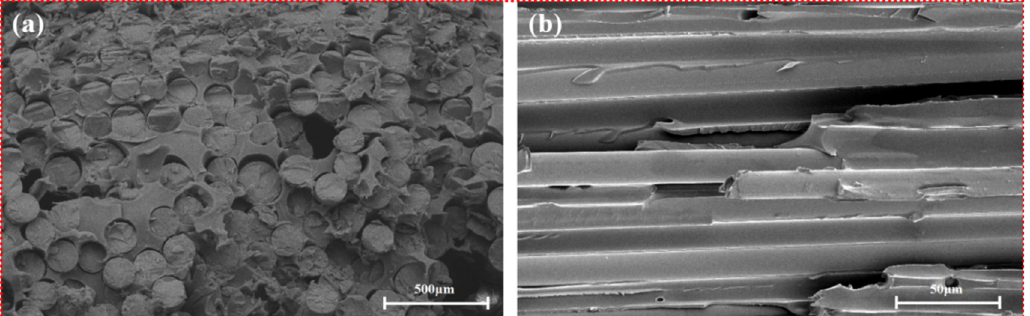
Figure 6. Microscopic morphology of GF-NOL: ( a ), 500×; ( b ), 500×.